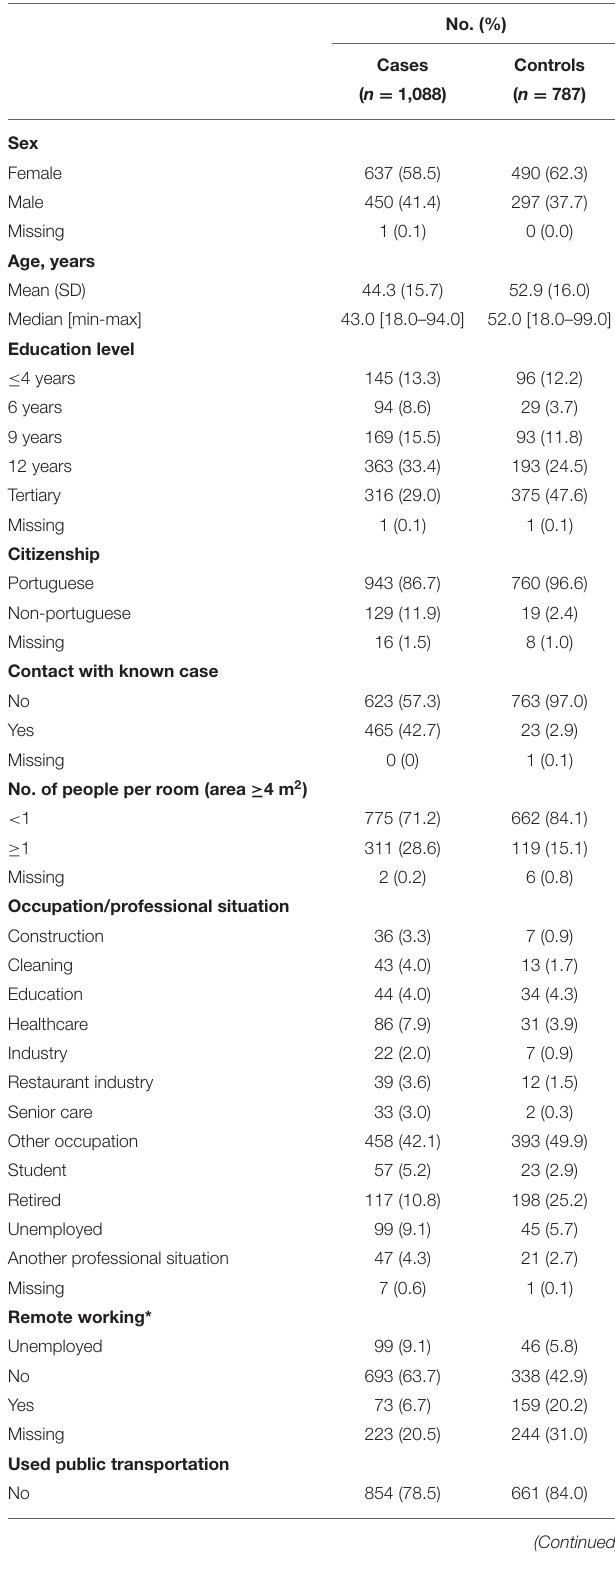
TABLE 1 | Sample characteristics according to sociodemographic aspects, contacts, and spaces among cases of SARS-CoV-2 and controls from the Lisbon and Tagus Valley Region in September and October